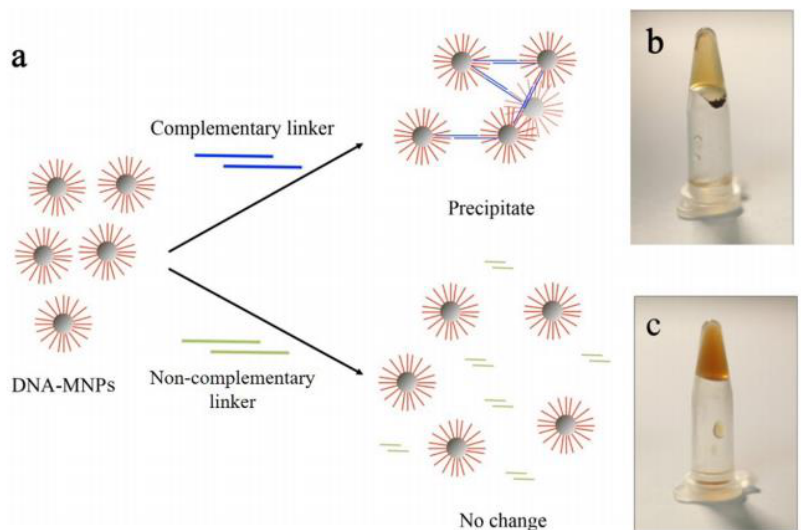
Figure 7. ( a ) Schematic representation of the assembly of DNA linkers to the DNA functionalized magnetic nanoparticles, where ( b ) the complementary linkers produced a precipitant in 10 min, while ( c ) the non-complementary linkers did not result in any change. Reprinted from [40] with permission from American Chemical Society, 2017.